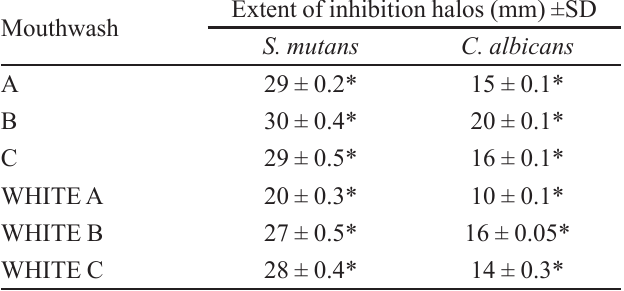
*Mean ± Standard deviation of triplicate analysis.